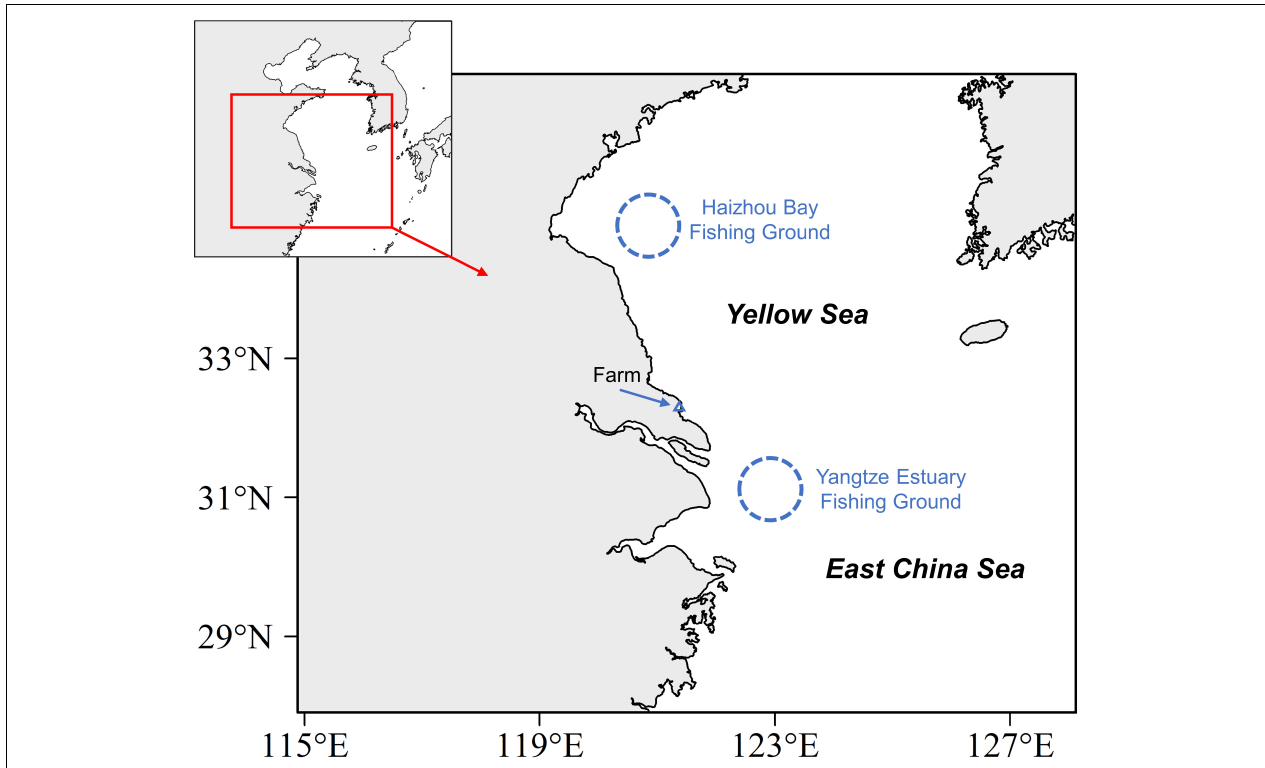
FIGURE 1 | Sampling areas of edible jellyfishes Rhopilema esculentum and Nemopilema